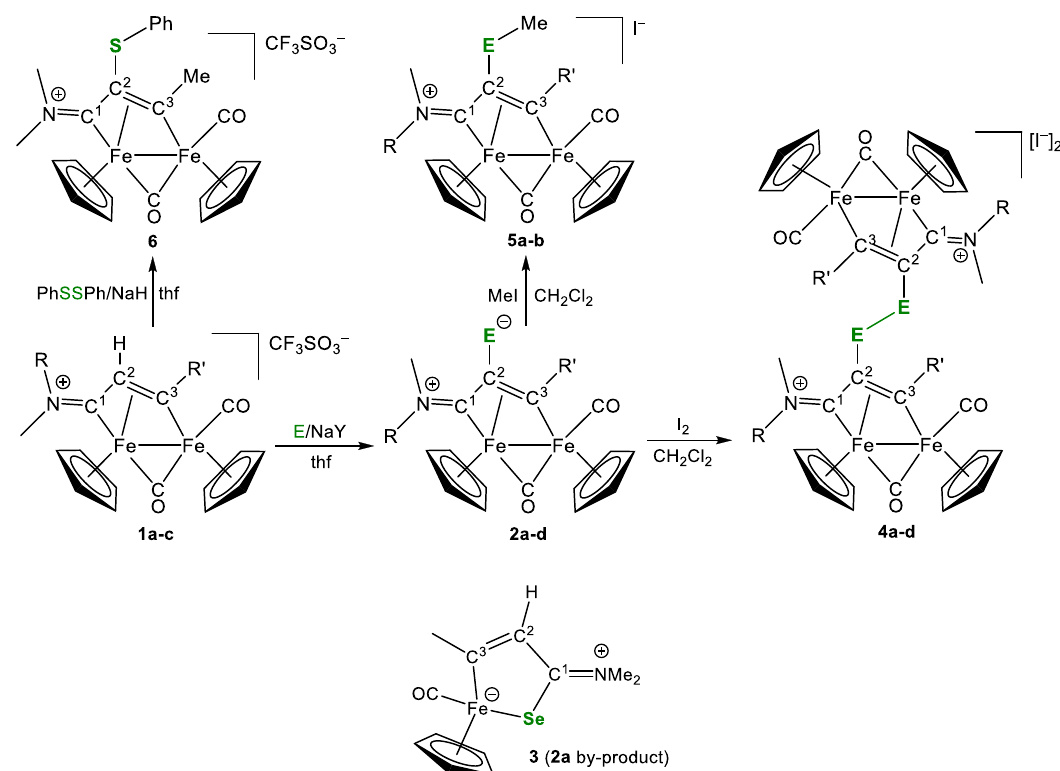
Scheme 2. Synthesis of functionalized mono-, di- and tetrairon complexes via reactions of diiron vinyliminium compounds with elemental sulphur/selenium (E) and PhSSPh. 1a : R = R ’ = Me; 1b : R =